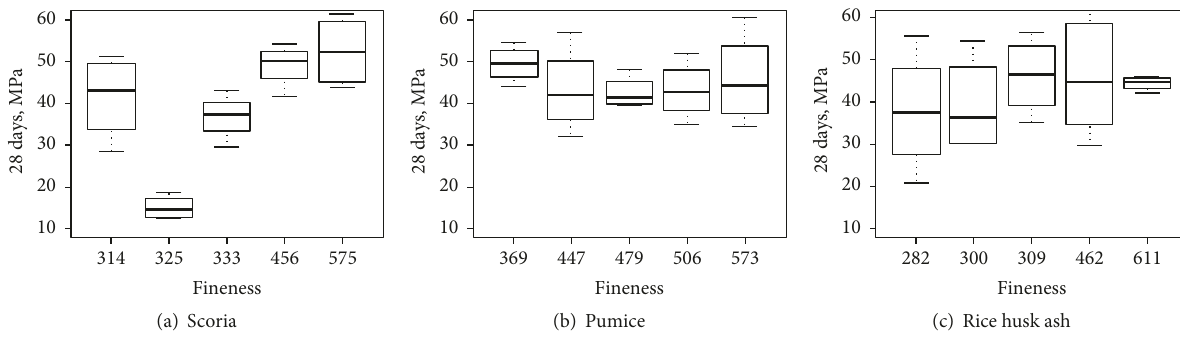
Figure 10: Effect of fineness on 28-day compressive